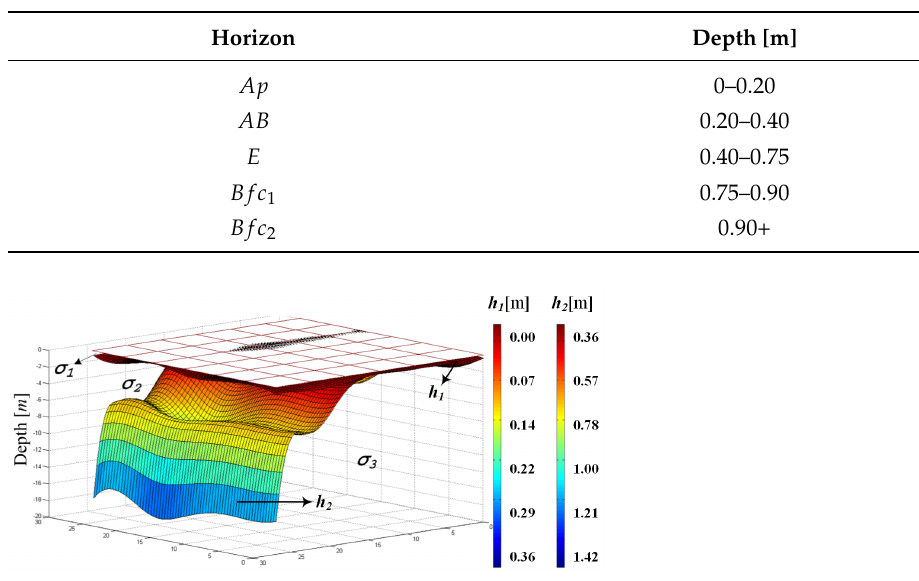
Figure 20. View of 3D mapping for profile of Plinthosol.